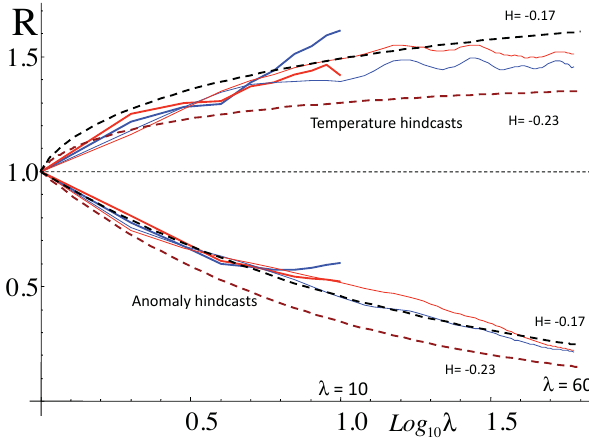
Figure 5. The dimensionless ratios ( R ) of the hindcast error vari- ances to the variance at the smallest resolution and horizon t equal to the resolution τ for both temperature with horizon λτ and resolu- tion τ (top; R =(cid:104) E T ( λτ,τ ) 2 (cid:105) / (cid:104) E T ( τ,τ ) 2 (cid:105)= 1 + (2 + 2 H ) F H ( λ )) and anomaly, with horizon λτ and resolution λτ (bottom; R =(cid:104) E T ( λτ,λτ ) 2 (cid:105) / (cid:104) E T ( τ,τ ) 2 (cid:105)= λ 2 H ). The red lines are global series; the blue lines are Northern Hemisphere series. The thick, shorter curves are at annual resolution ( τ = 1 year) and the thin, longer lines are at a monthly resolution ( τ = 1 month). Also shown (dashed) are the theory curves for H =− 0.17, − 0.23 (top (black) and bottom (brown) of each dashed pair respectively). The data closely follow the H =− 0.17 curves. The standard deviations at the highest-resolution (cid:104) E T ( τ,τ ) 2 (cid:105) 1 / 2 are given in Table 4. This plot has no adjustable